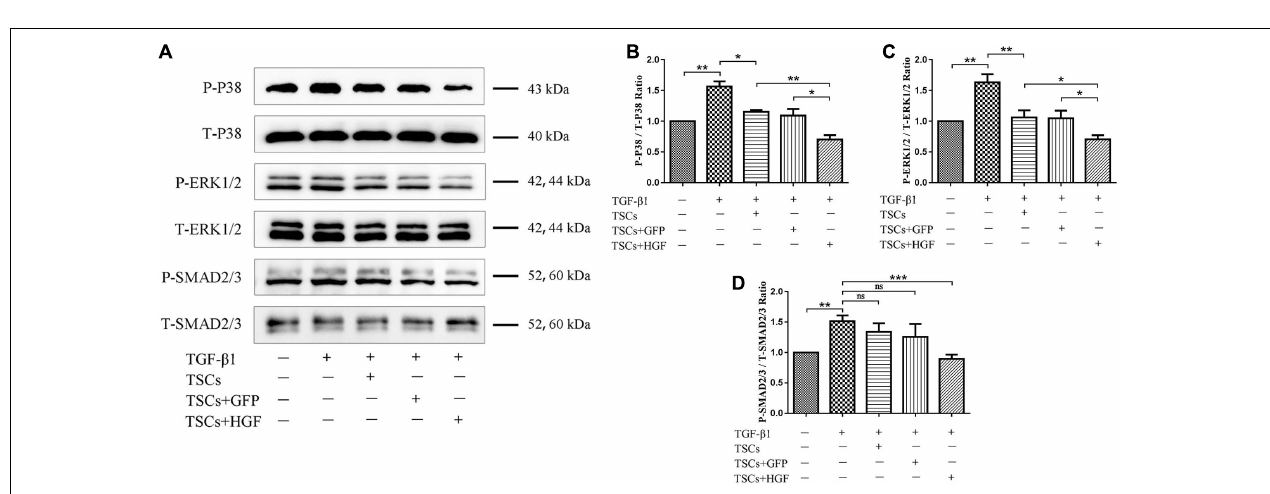
FIGURE 7 | TSC and tendon fibroblast coculture system and levels of fibroblast inflammatory and fibrotic proteins. (A) An indirect coculture model system. (B) WB images of COX-2, COLIII, and α -SMA. Quantitative analysis of (C) COX-2, (D) COL III, and (E) α -SMA ( n = 3). Data are represented as mean ± SD. * P < 0.05, ** P < 0.01, *** P < 0.001.